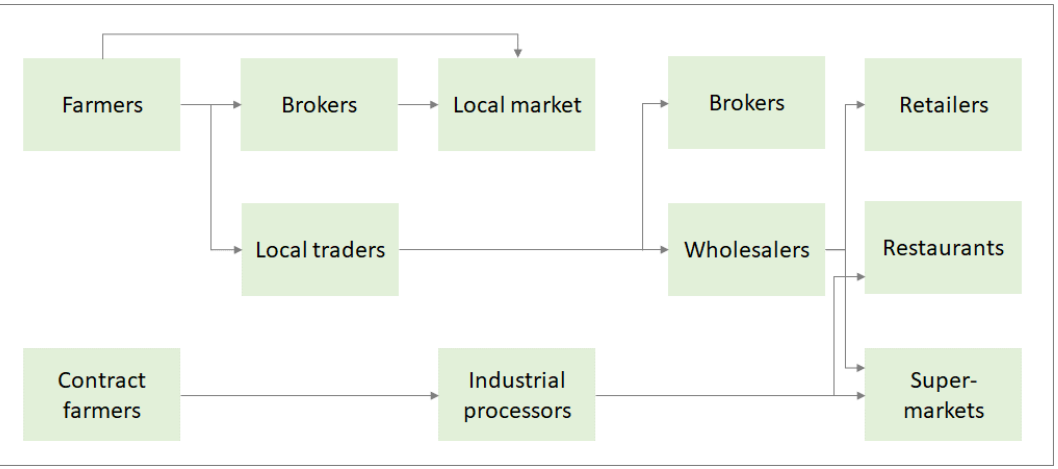
Figure 1. Potato Supply Chain in Kenya [14].